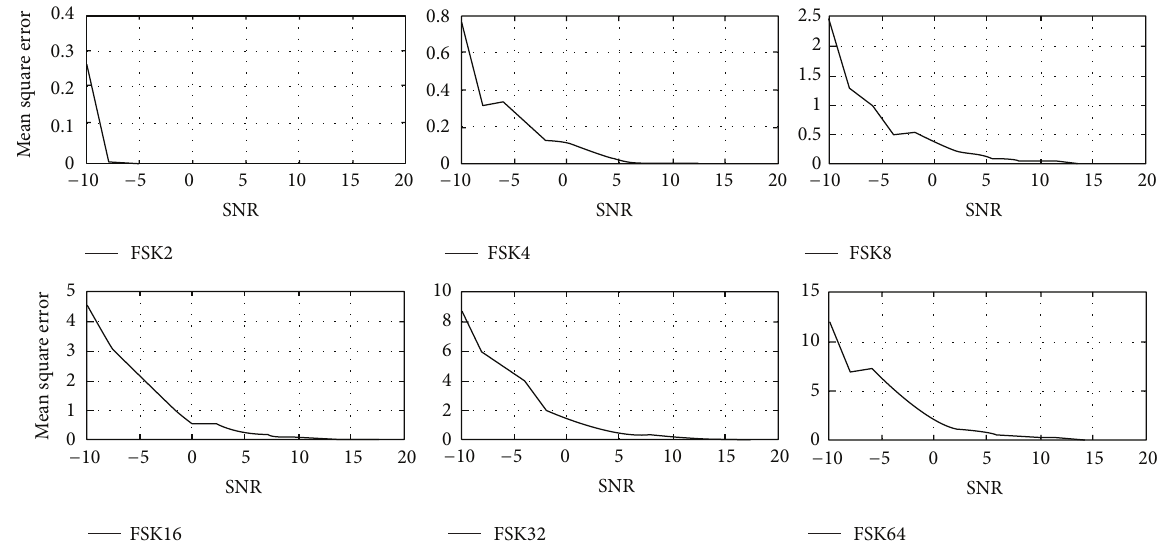
Figure 7: Training of Gabor filter parameters and weights for modulation classification in case of PSK modulation 2–64 at different SNRs and fixed number of iterations.